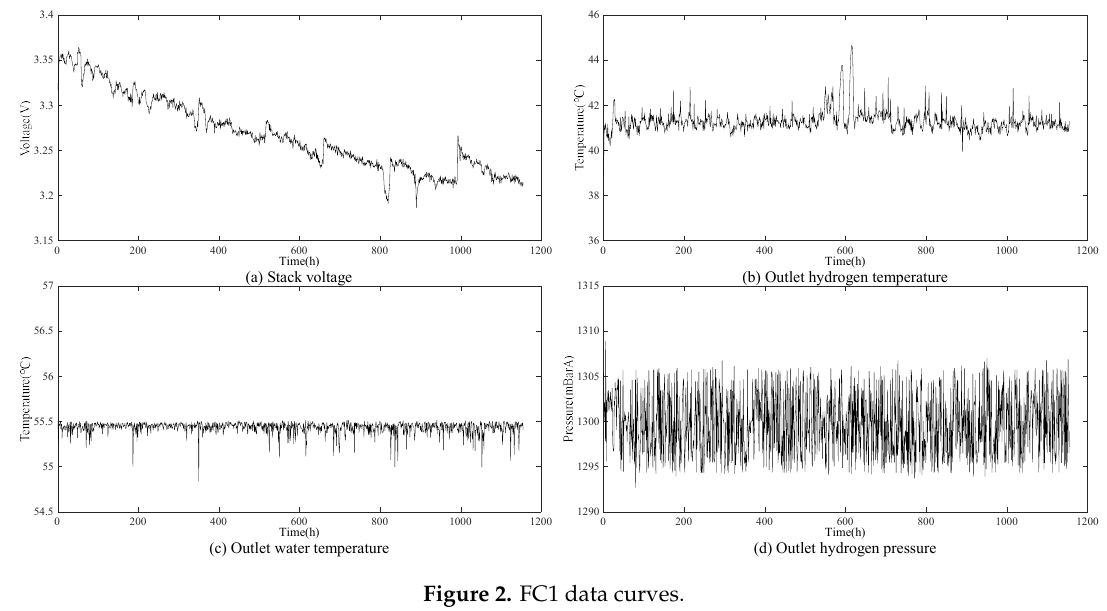
Figure 2. FC1 data Figure 2. FC1 data curves.